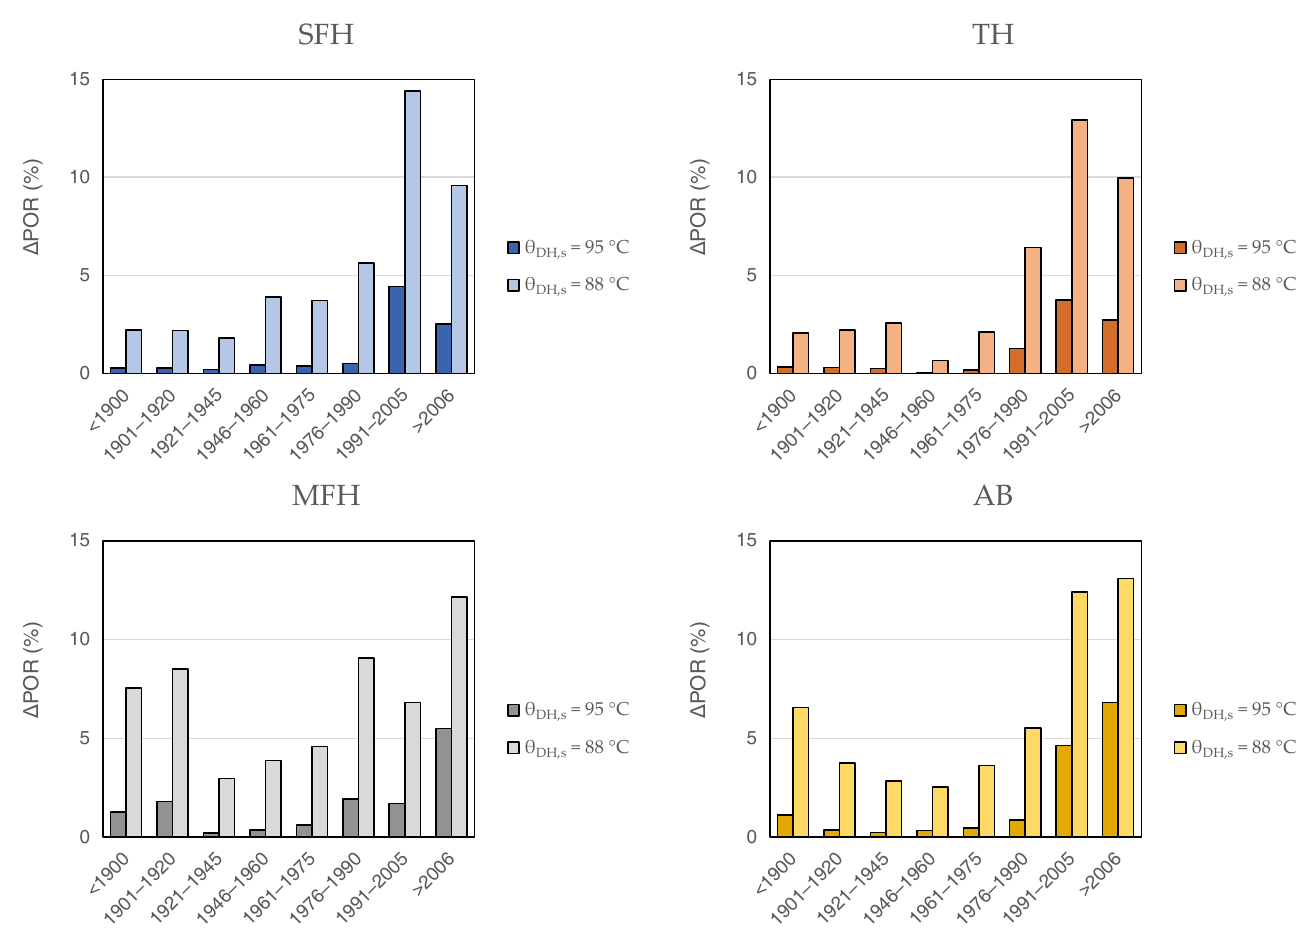
Figure 3. Variation of percentage outside range (POR) parameter with decreased district heating (DH) temperature (115 ◦ C to 95 ◦ C and 115 ◦ C to 88 ◦